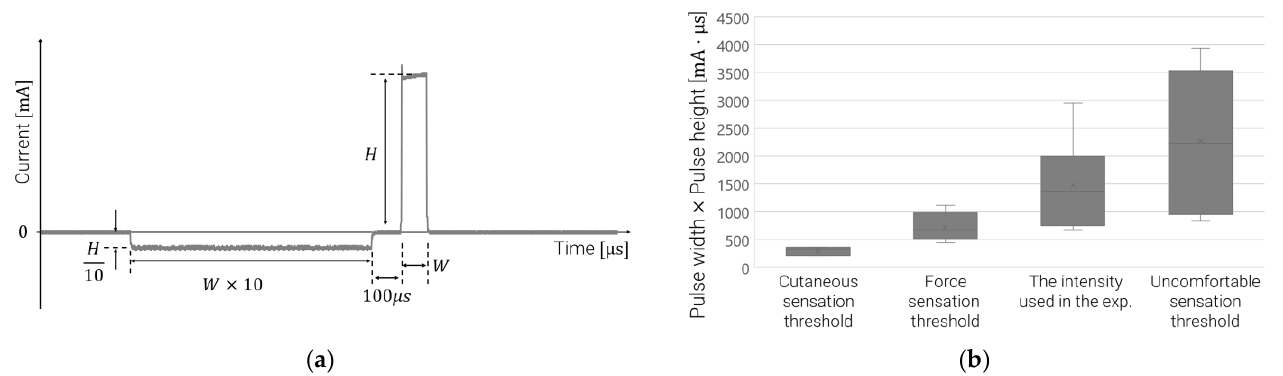
Figure 3. ( a ) Electrical stimulation’s waveform. ( b ) Electrical current pulse intensity, whose value is equal to W × H [ mA · µ s ] .